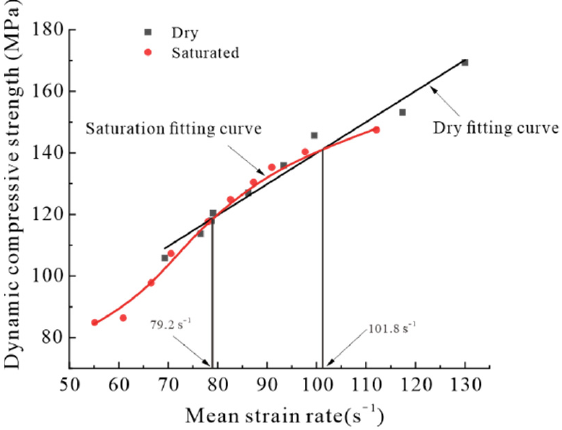
Figure 8. Dynamic compressive strength versus average strain rate curve. The patterns of deformation damage for phyllite samples after uniaxial compression tests with different water-bearing states at different stratification angles are shown in Figure 9.